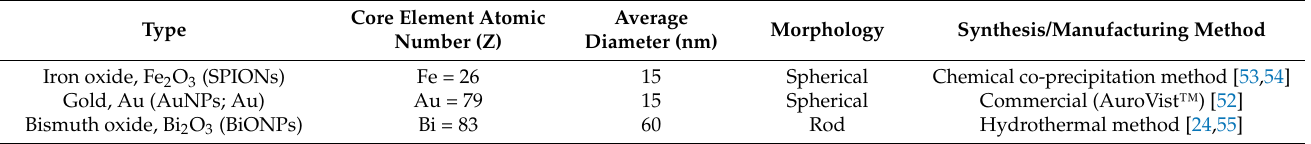
Table 1. Summary of properties for SPIONs, AuNPs and BiONPs.